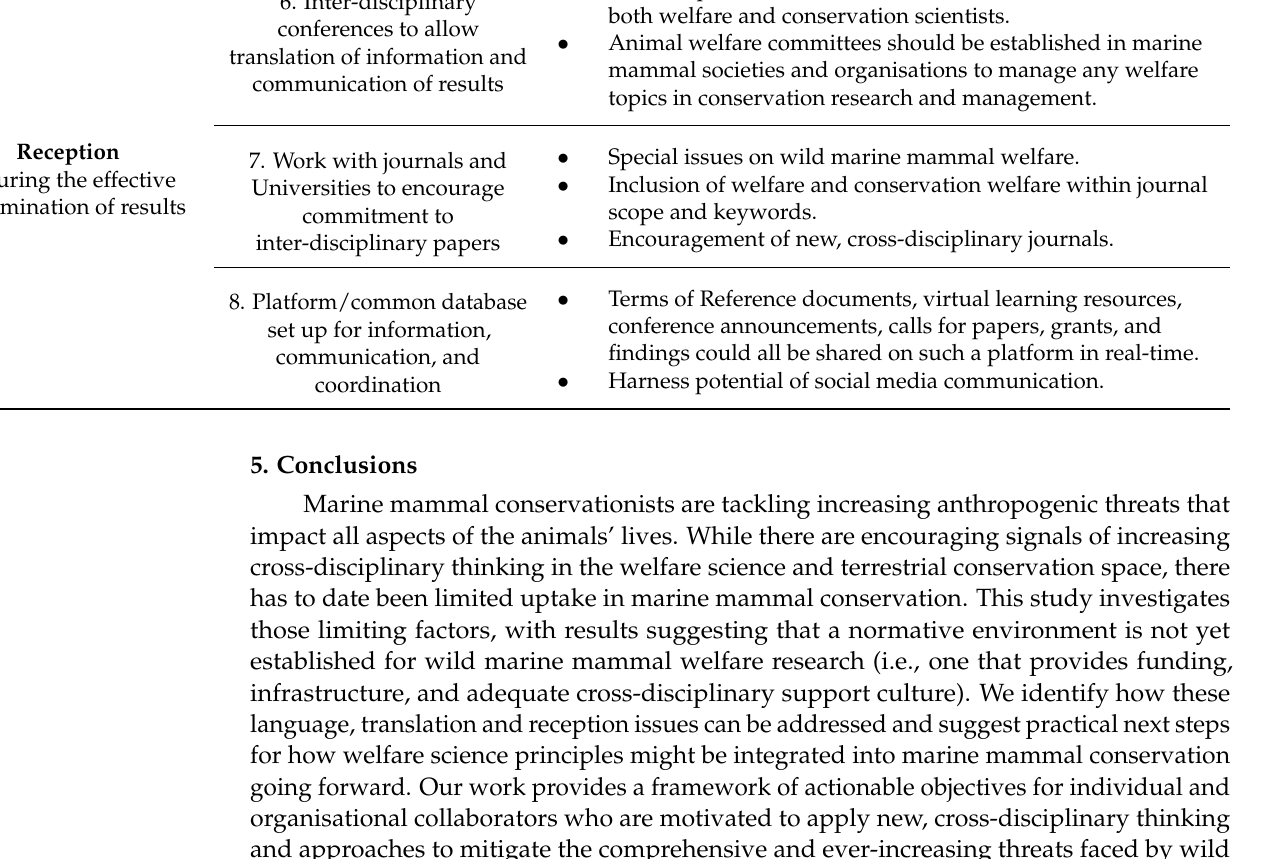
Table S2: Results of selected survey questions described in the main body of the manuscript; Table S3: Categorisation of journals into types depending on